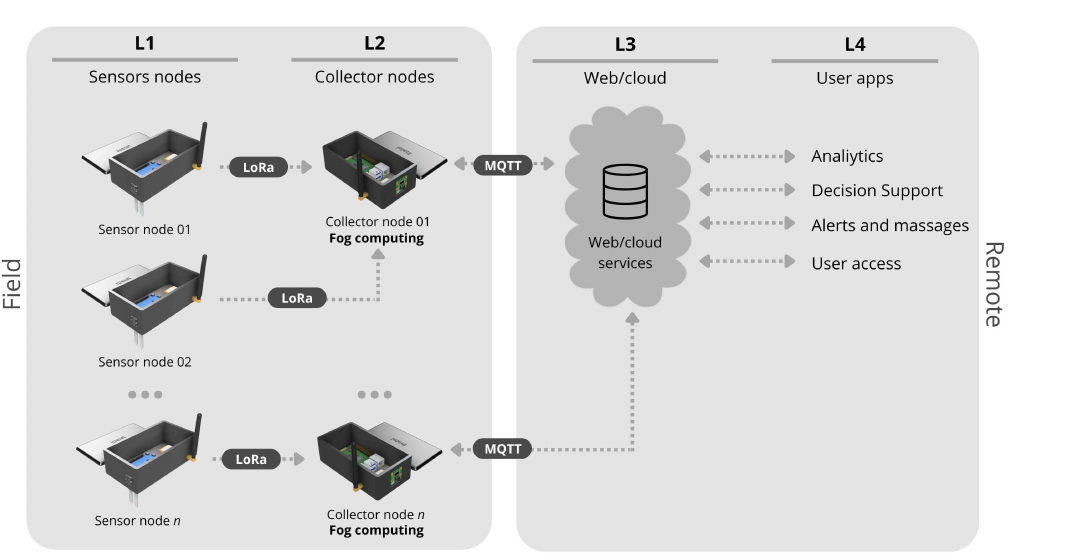
Figure 2. Layers of the IoT architecture.